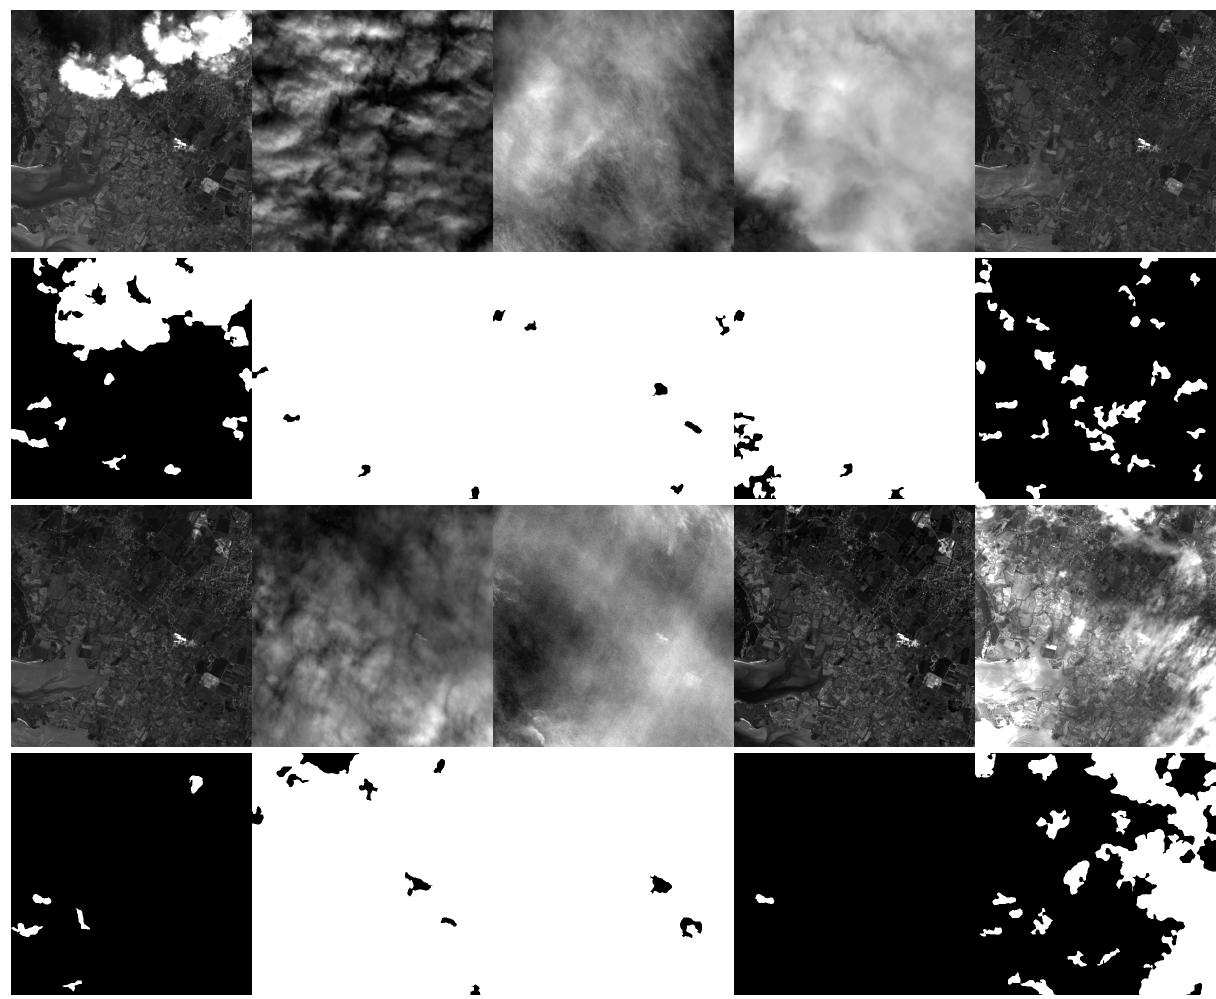
Figure 4. Ground visibility computed by the algorithm of (Dagobert et al., 2019) in a time series of ten images from the Sentinel-2 constellation. First and third rows: input images. Second and fourth rows: resulting ground visibility maps, where black pixels correspond to visible while white corresponds to not visible . The images are 496 × 496 and the ten ground visibility masks were jointly computed in about one minute and 20 seconds on an 1.2 GHz Intel Core M